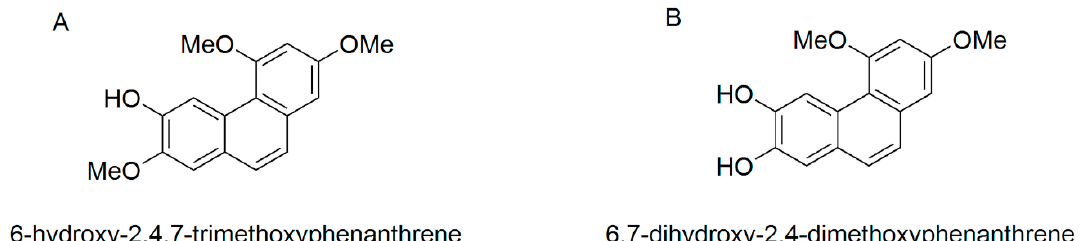
Figure 1. Molecular structure of ( A ) 6-hydroxy-2,4,7-trimethoxyphenanthrene (PC2) and ( B ) 6,7-dihydroxy-2,4-dimethoxyphenanthrene (PC4).